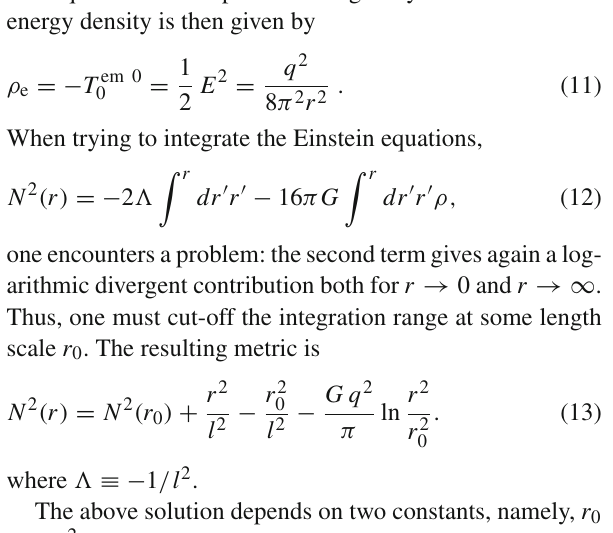
Fig. 1 Zeros of the function N 2 ( x ) in (19) for N 2 obtained from the plot of the functions x 2 − 2 and x 2 ln x 2 . In the above label log stands for ln. By increasing N 2 along the direction of the arrow and one or two intersections on the positive real axis can